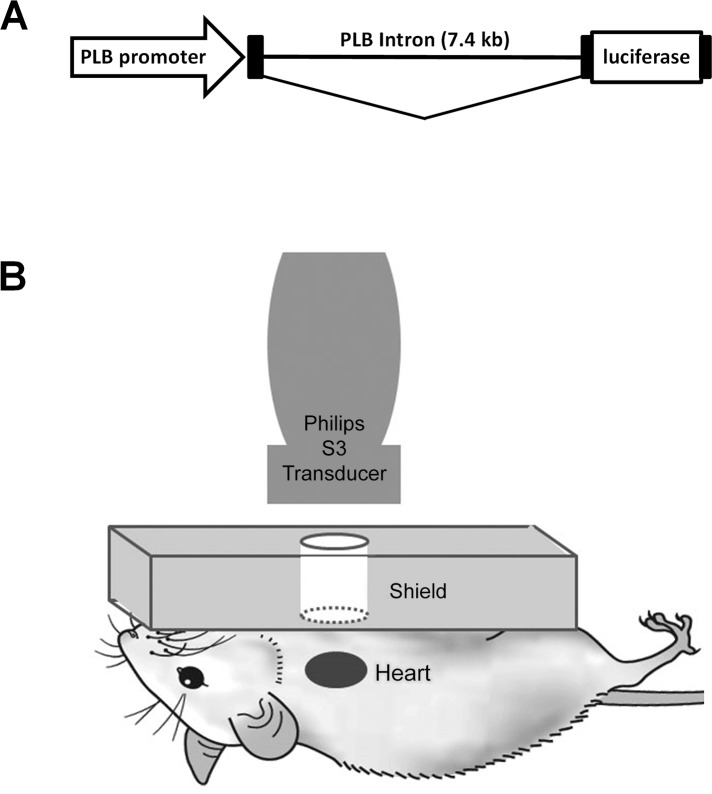
Experimental Design.(A) Schematic of rat phospholamban promoter/luciferase gene fusion used to generate transgenic mice. (B) Transducer and shield arrangement for cardiac delivery in siRNA in vivo. All elements are acoustically coupled using ultrasound gel.